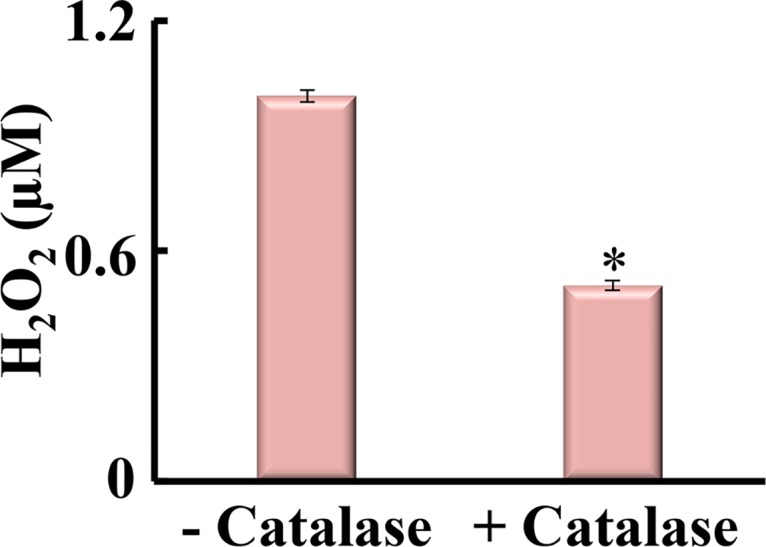
Effect of catalase, an H2O2 scavenger, on intra-oocyte H2O2 concentration (n = 20).The error bars represent the standard errors of mean.